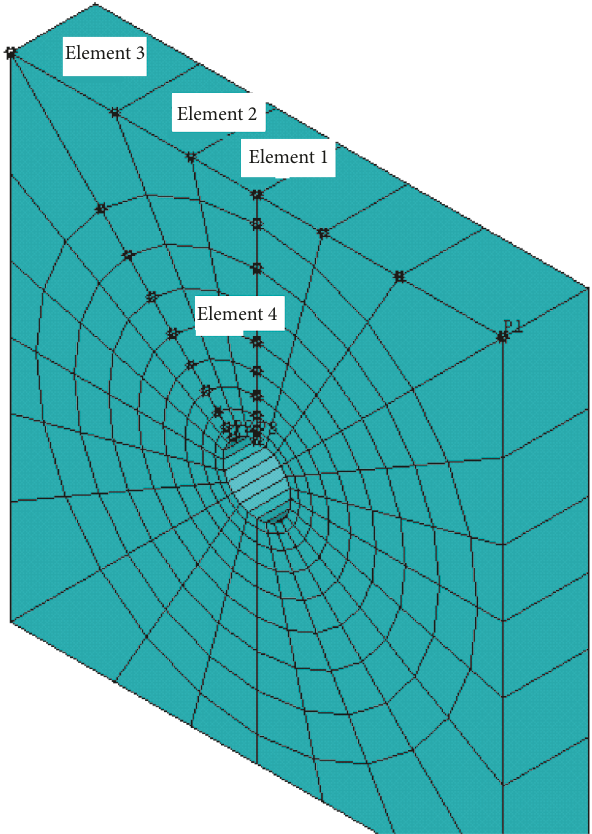
Figure 14: Locations of elements 1–4.